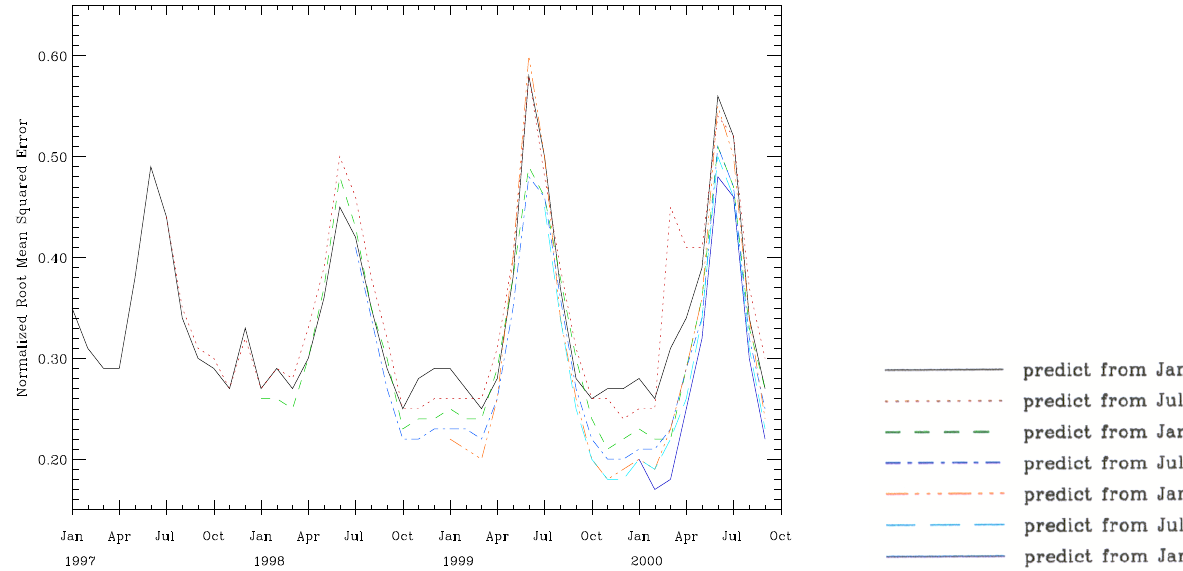
Fig. 2. Normalized root-mean-squared errors for 1-hour ahead forecasts of fo F2 from January 1997 to October 2000.